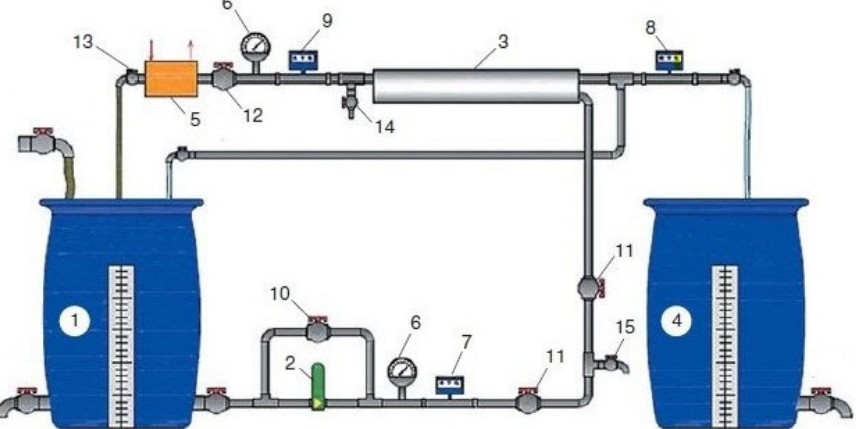
Figure 5. Experimental test membrane unit flow diagram: 1—tank for the feed water; 2—working pump; 3—membrane element in the pressure vessel; 4—permeate collection; 5—heat exchanger; 6—manometer; 7–9—flow meters; 10—bypass valve; 11—flow and pressure regulation valve; 12—pressure regulation valve; 13—valve for adjusting the flow of cooling water; 14,